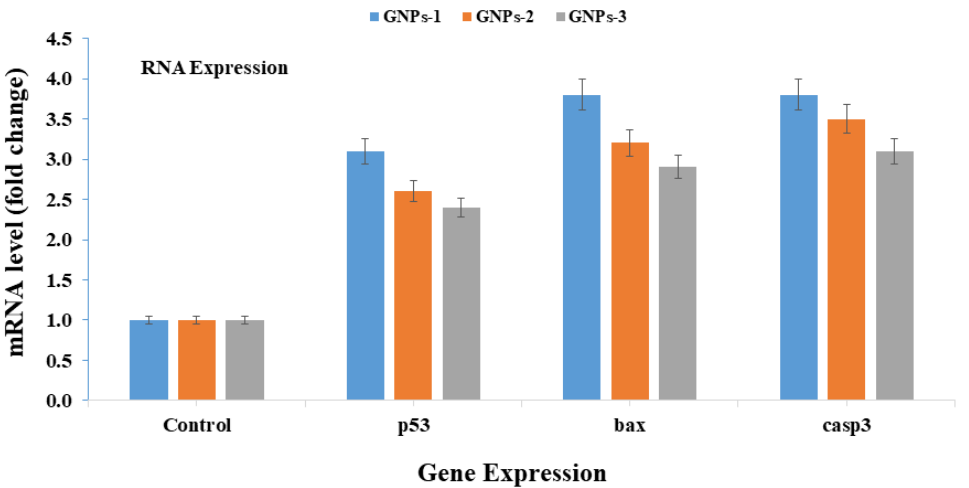
Figure 8. Quantification of mRNA fold change and apoptotic genes (p53, Bax, and casp3) were evaluated. HepG2 cells were treated with 25 µ g/mL of GNPs-1, GNPs-2, and GNPs-3 for 24 h. For internal control, glyceraldehyde 3-phosphate dehydrogenase (GAPDH) was used. The values are mean ± SE of three independent experiments.